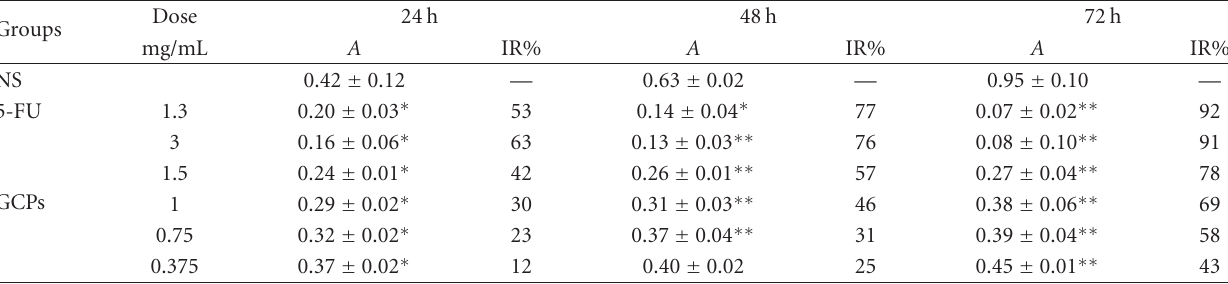
Table 1: Inhibition e ff ect of Gecko-contained serum on HepG2 by MTT assay (mean ± SD, n = 12). Groups